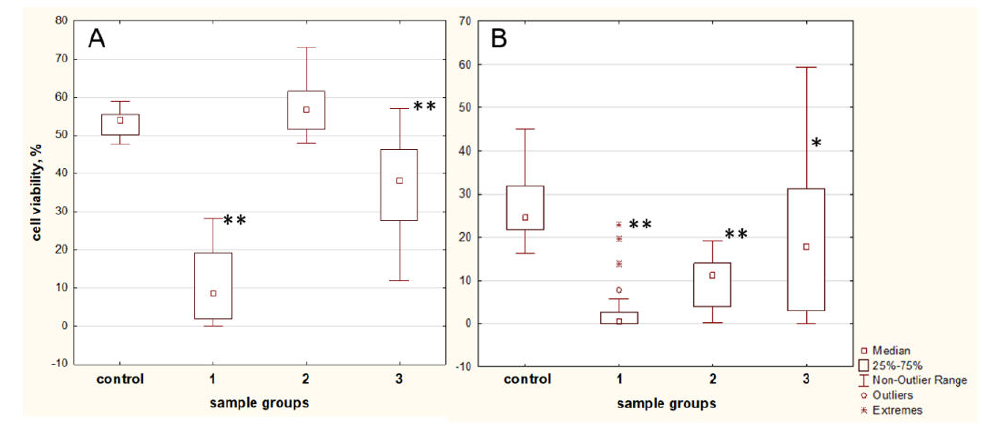
Figure 8. Antioxidant properties of blood plasma samples of T2D patients assayed by the MTT assay on the H 2 O 2 oxidative stress model. ( A ) 5% v / v and ( B ) 0.5% v / v of plasma samples added to MSCs culture media before 100 µ M H 2 O 2 treatment for 24 h. Abbreviations: Plasmas of healthy donors are presented as a control group; 1, 2, 3—plasma samples of T2D patients. 1—low antioxidant activity, cell viability less than 25%; 2—elevated antioxidant activity compared with control group; 3—antioxidant activity, cell viability in the range of 25–50%. Data are shown as median (interquartile range). * p < 0.05, ** p < 0.01 compared with control